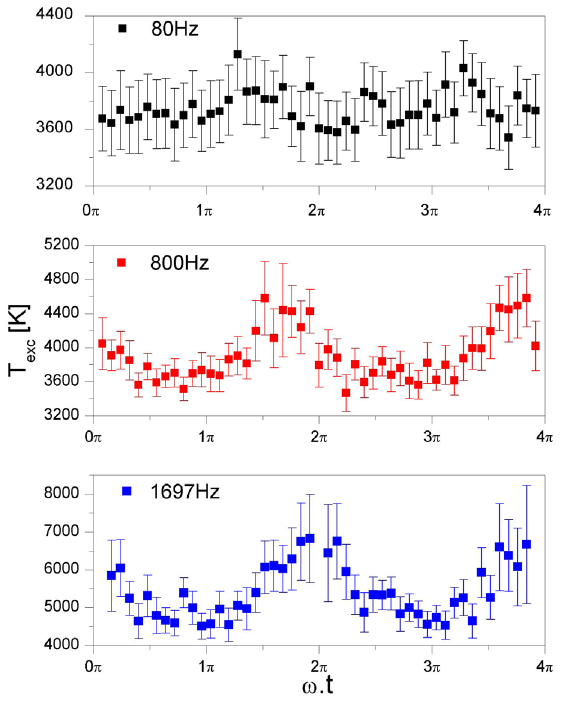
Figure 3 : Time-resolved excitation temperature 2 mm outside the discharge tube calculated from Ar I lines for three AM frequencies.